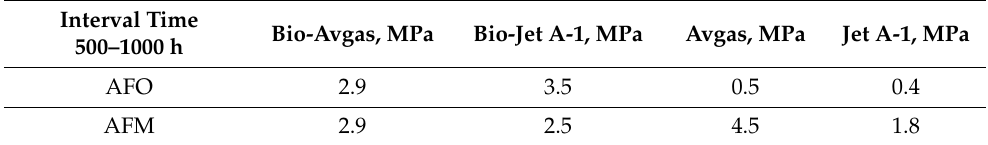
Table 3. Experimental contact pressure drop values of the AFM and AFO gaskets for different fuels at the 500–1000 h time interval.